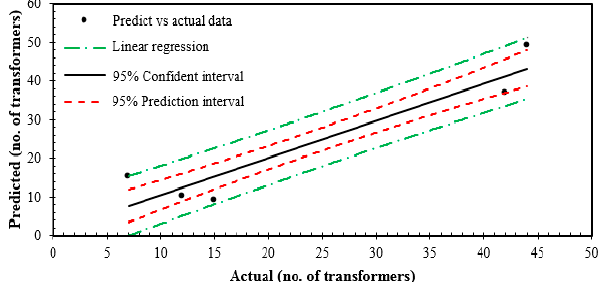
Figure 5. Predicted versus actual numbers of transformer in the year 2015 based on transformer transition states for the year 2013/2014.